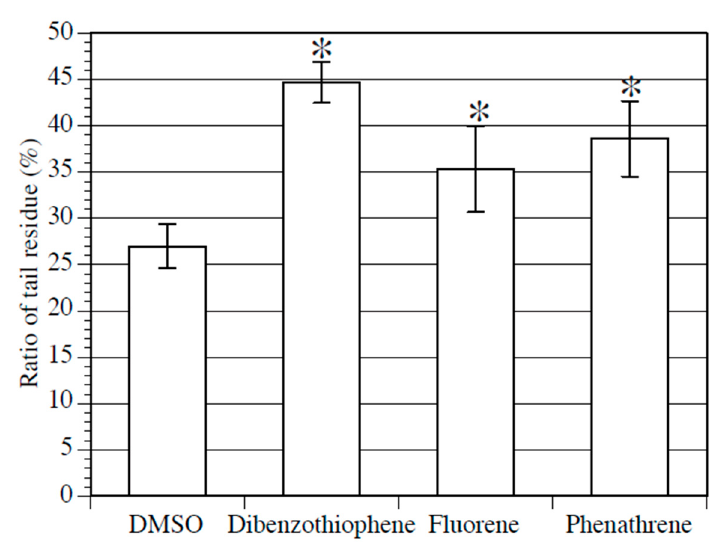
Figure 2. Effect of PAHs on Ciona metamorphosis. The ratio of tail residue diameter to body length in juveniles treated with 0.2% DMSO (negative control), 100 μ M dibenzothiophene, 100 μ M fluorene, or 100 μ M phenanthrene from swimming larvae (20 hours after fertilization) to juveniles (90 hours after fertilization) stages. Mean values of five biological replicates are represented with standard deviations. Approximately 50 embryos were examined in each experiment. Asterisks indicate significant differences ( p < 0.05; Dunnett’s test).